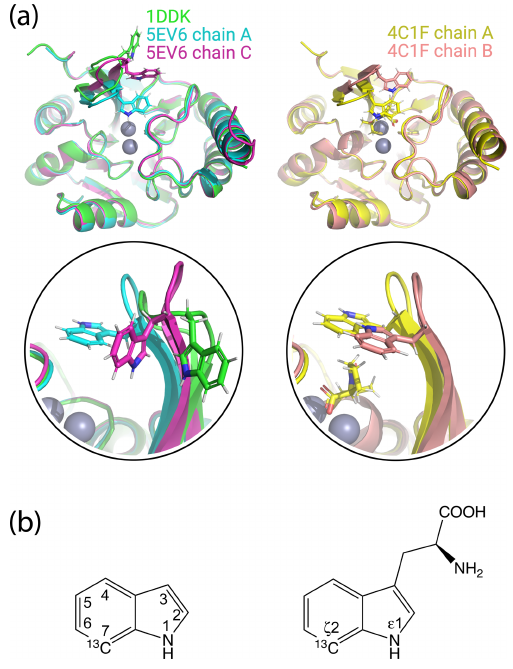
Figure 1. Crystal structures of IMP-1 with different conformations of the loop L3 and chemical structures of indole and tryptophan with atom names. (a) Superimposition of crystal structures of IMP- 1 highlighting structural variations of Trp28 and the associated loop L3. The structures shown are of the Zn 2 + /Zn 2 + complex without an inhibitor (green, PDB ID 1DDK, Concha et al., 2000; cyan for chain A and magenta for chain C, PDB ID 5EV6, Hinchliffe et al., 2016), with bound L-captopril (yellow for chain A and salmon for chain B, PDB ID 4CIF, Brem et al., 2016). Zn 2 + ions are repre- sented by grey spheres and bound captopril is shown in the struc- ture 4C1F chain A. (b) Chemical structures of indole and trypto- phan with selected ring positions labelled according to IUPAC con- ventions. The present work used indole synthesised with a 13 C- 1 H group in position 7 and deuterium in ring positions 2, 3, 4, 5 and 6 (Maleckis et al.,